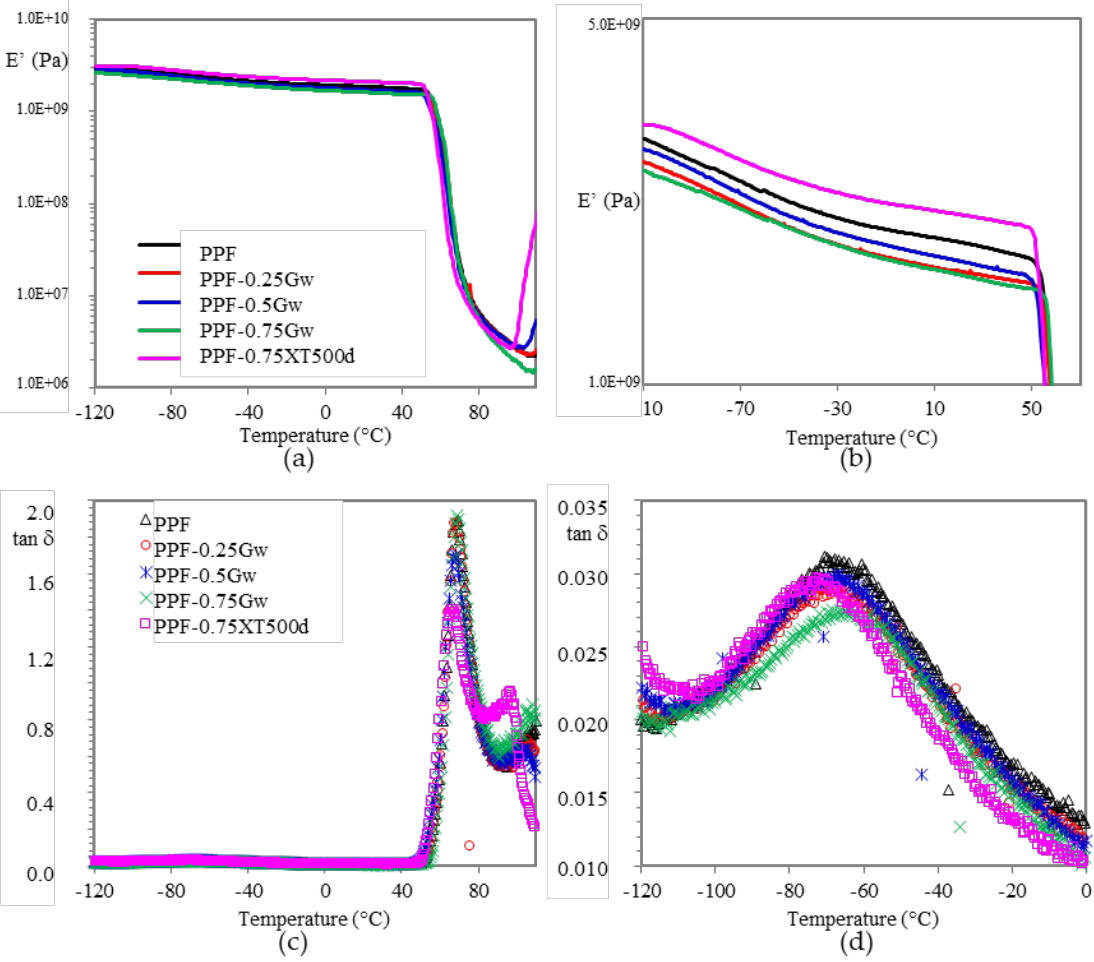
Figure 9. ( a ) Storage modulus E’ vs. T in PPF samples and ( b ) zoomed region; ( c ) tan δ vs. T and ( d ) zoomed region.